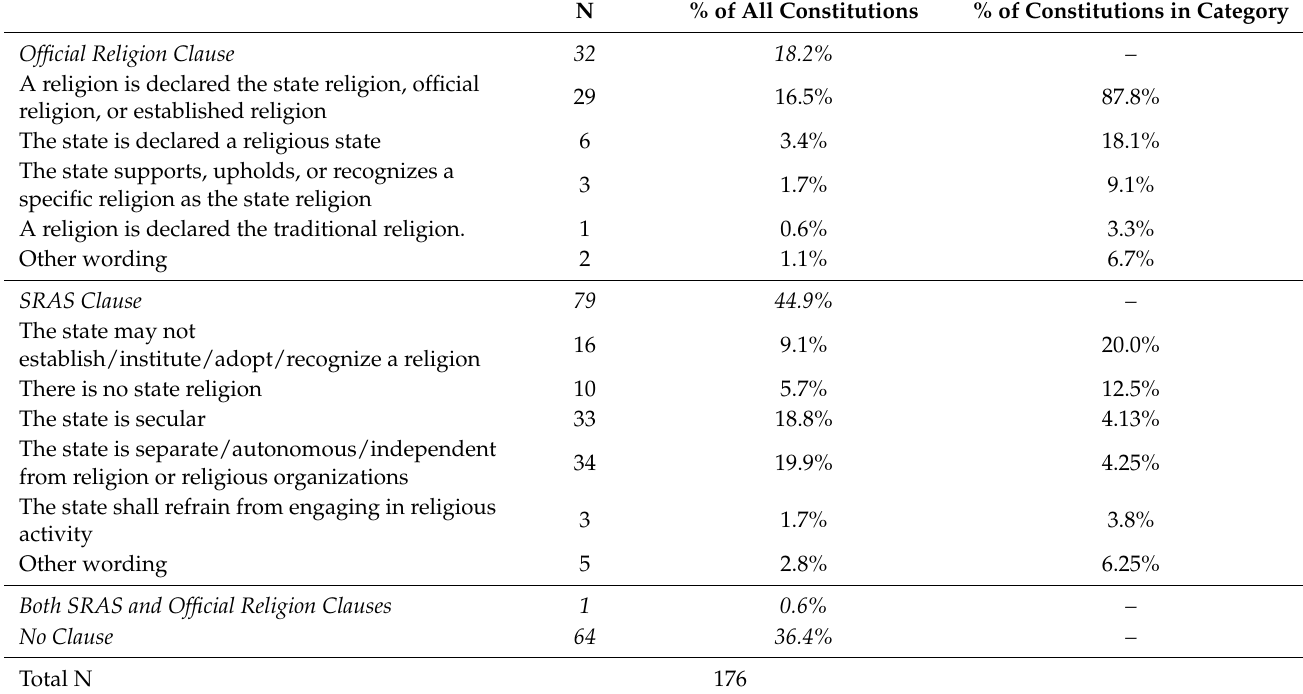
Table 1. Official Religion and SRAS Clauses with Specific Wording in